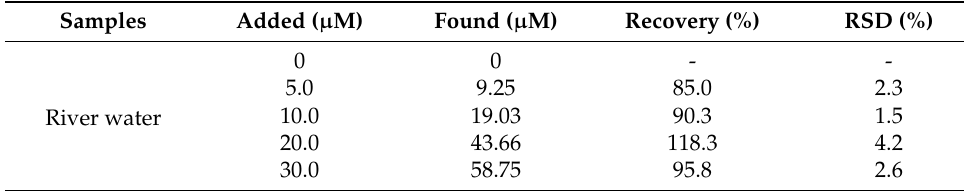
Table 1. Determination of BPAF in river water ( n =